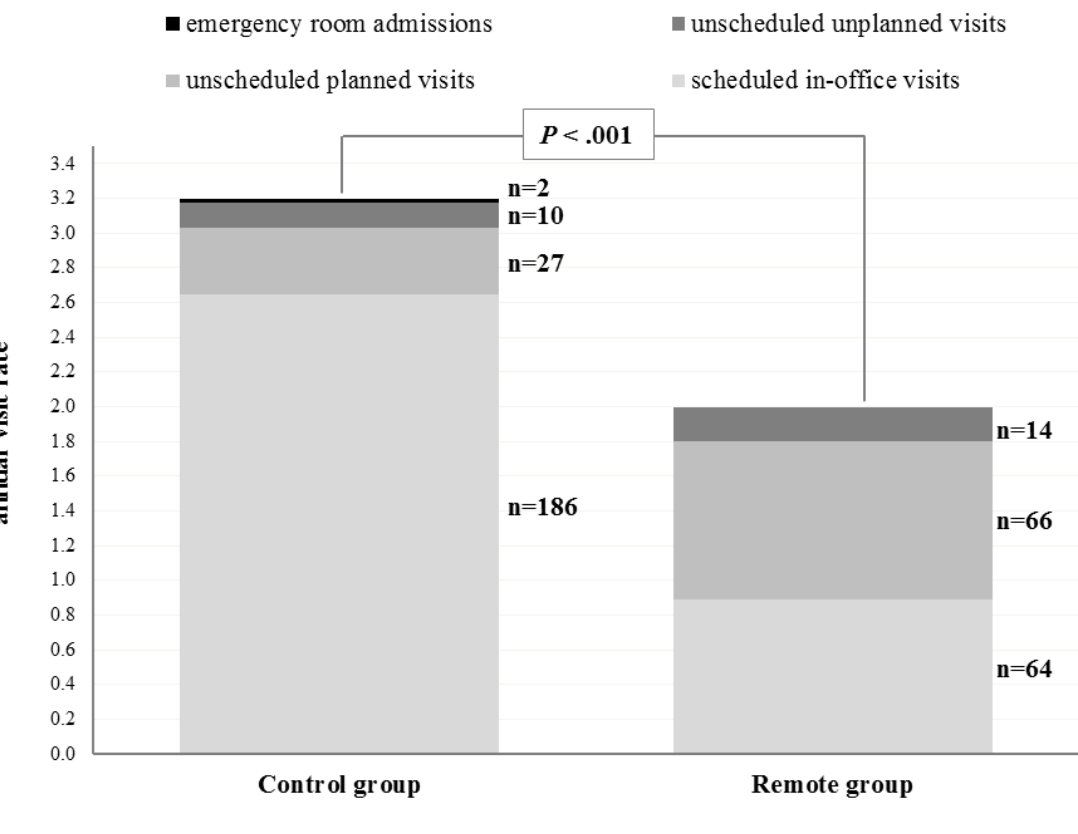
Figure 6. Annual rates per randomization group of scheduled visits (in-office visits performed as per protocol requirement), unscheduled planned (in-office visits not required by the protocol, not patient initiated), and unplanned visits (in-office visits not required by the protocol, patient initiated) and emergency room admissions (for each randomization group and for each type of visit, the total number of occurrences is displayed beside the corresponding